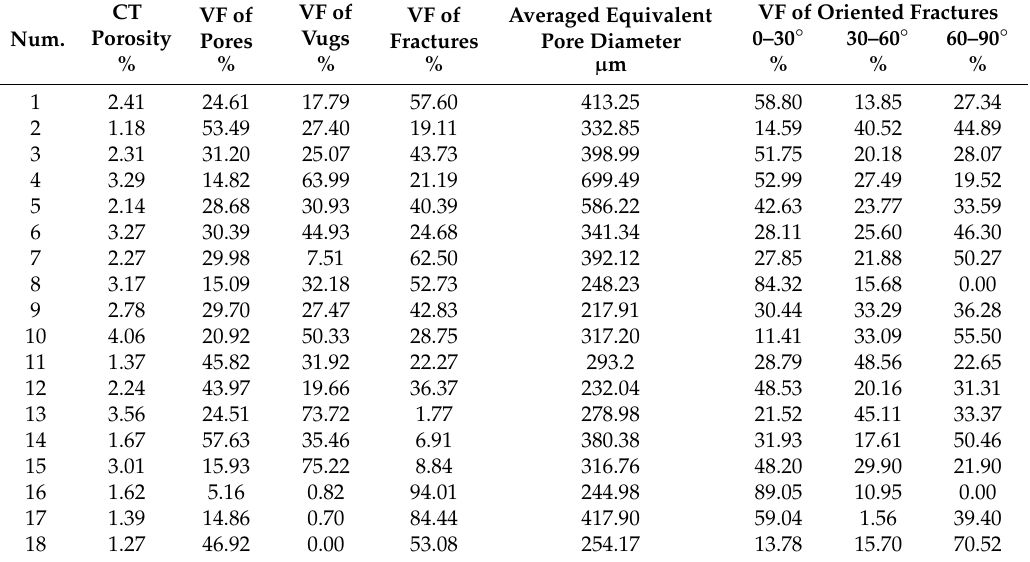
Table 2. Pore structural parameters obtained from the constructed pore space. ‘VF’ represents volume fraction. The VF of pores, vugs, or fractures equals the ratio of the volume of them over that of the total pore space, respectively. The orientation of the fractures parallel or perpendicular to the ends of the core plug is defined as 0 ◦ or 90 ◦ , respectively. The VR of oriented fractures equals the ratio of the volume of the fractures oriented in a certain angle range, for example, 0–30 ◦ , over that of all fractures. Num.